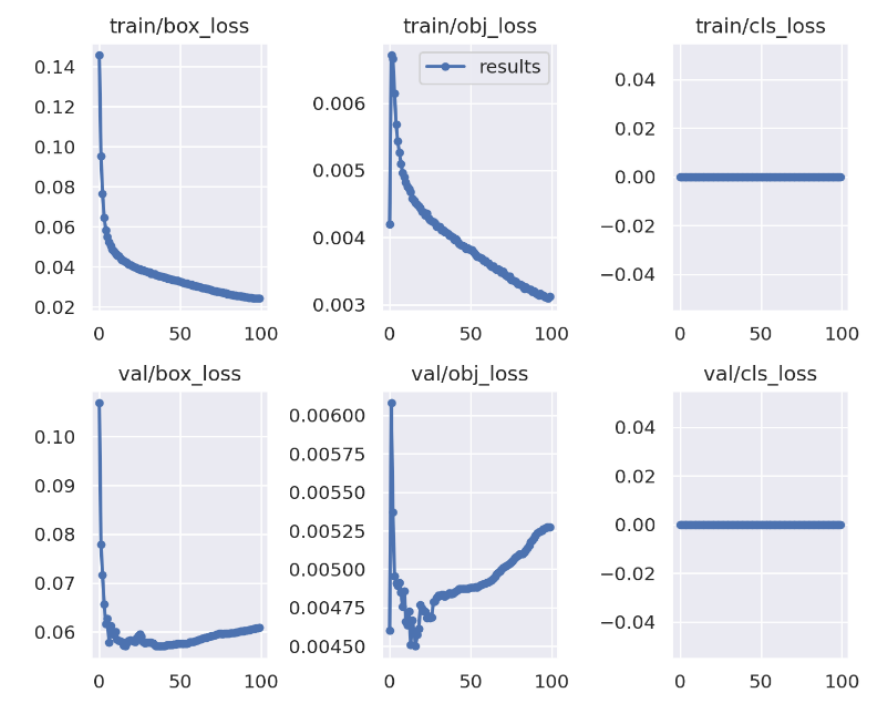
Figure 13. Training on the SEAGULL—progress of metrics during the 100 epochs.